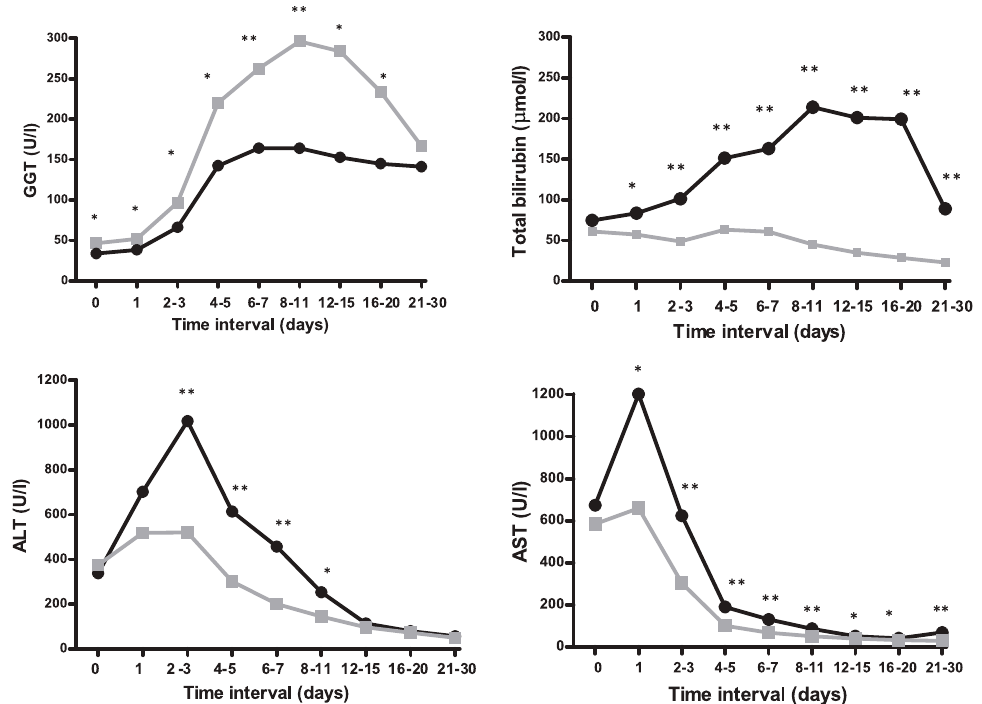
Figure 1. Evaluation of early post-LT laboratory variables (i.e. 0–30 POD) in early mortality. Curves represent patients who survived more than 90 days (gray) and those who did not (black). Median values are shown. * p <0.05; ** p ≤ 0.001. GGT, gamma glutamyl transpeptidase; ALT, aspartate aminotransferase; AST, alanine aminotransferase; TBI, total bilirubin.